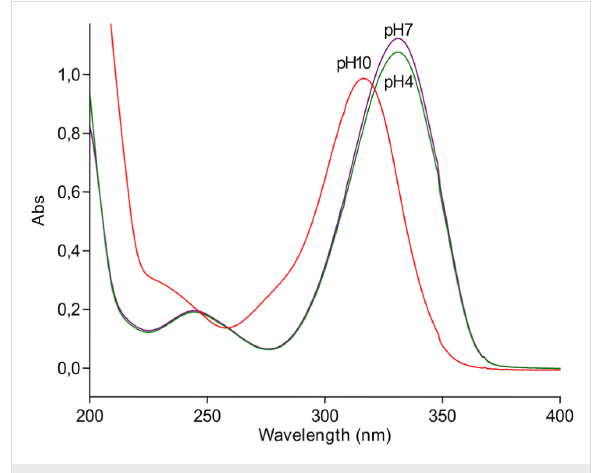
Figure 9: The UV spectra of 4-thio-2 ′ -deoxyuridine ( 1b ).